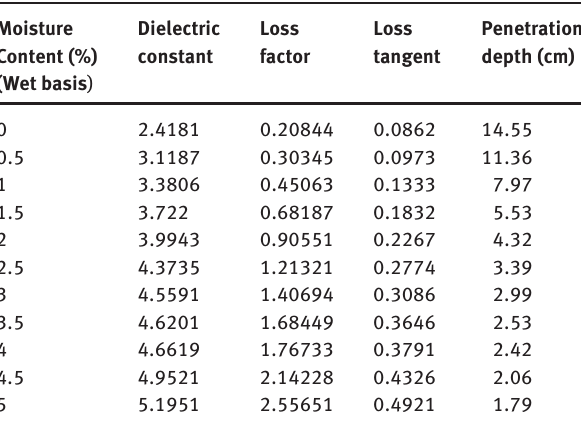
Fig. 4: Variation of dielectric constant of sodium chloride as a linear function of moisture content at 2.45